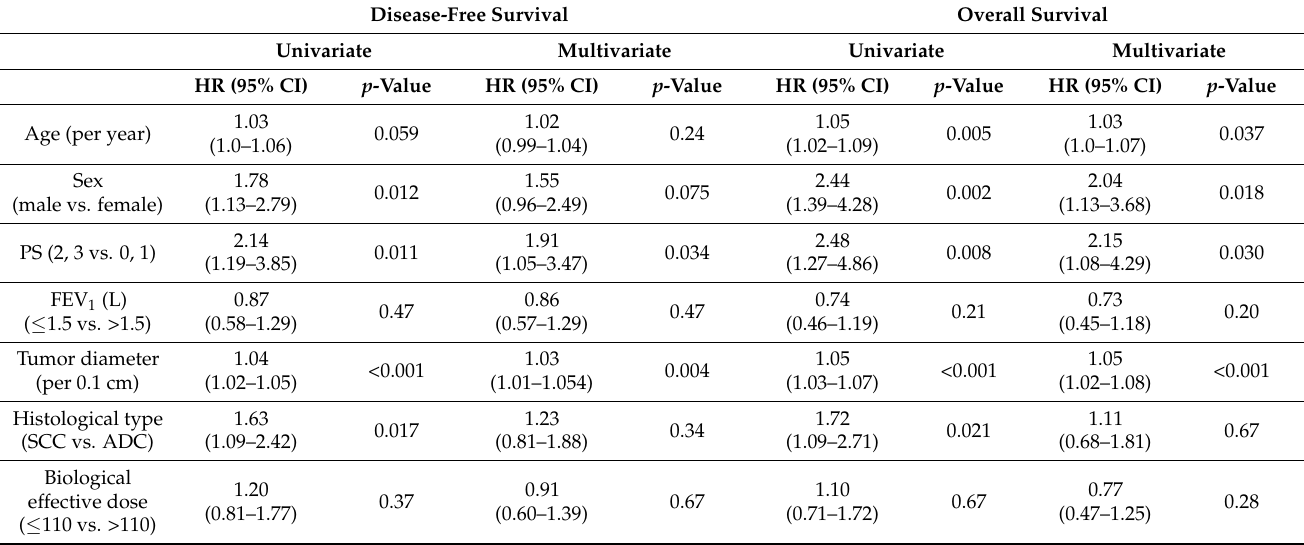
Table 2. Univariate and multivariable analyses of disease-free survival and overall survival. Disease-Free Survival Overall Survival Univariate Multivariate Univariate Multivariate